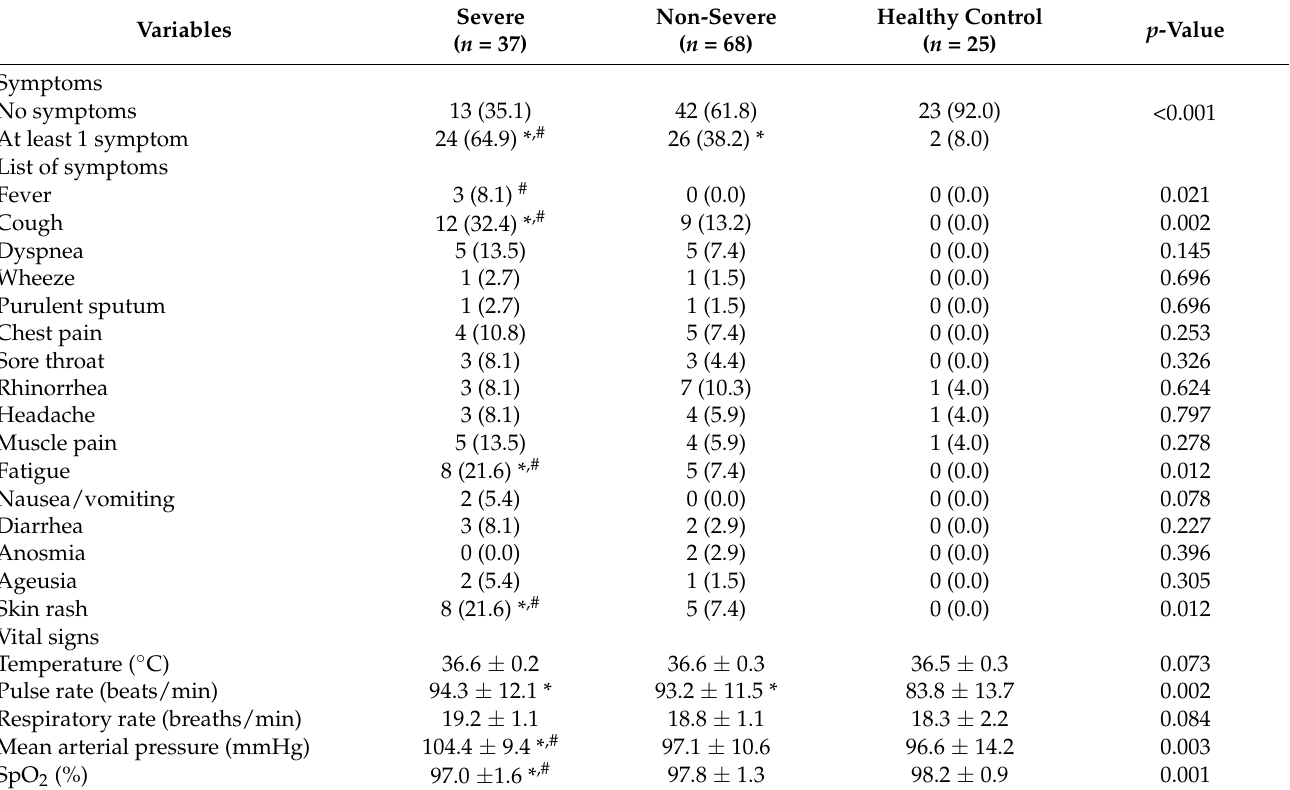
Table 3. Symptoms and vital signs at one-month follow-up